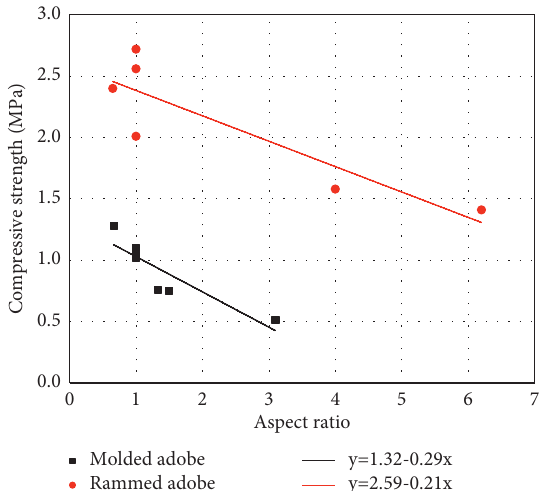
Figure 6: Mean compressive strength versus aspect ratio for various